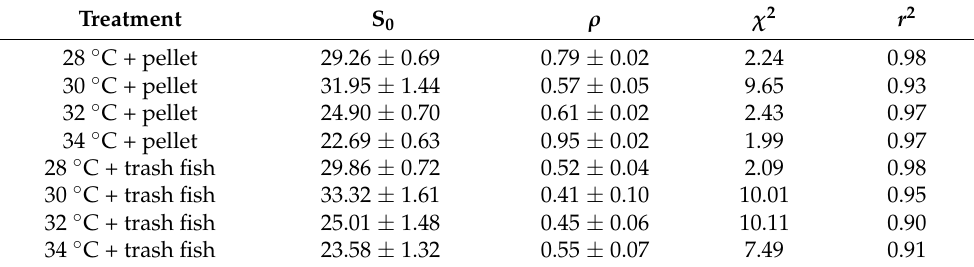
Table 2. Summary statistics for parameter estimation of the square root model in stomach residuum for the adult hybrid Sabah grouper (the values are obtained from Figure